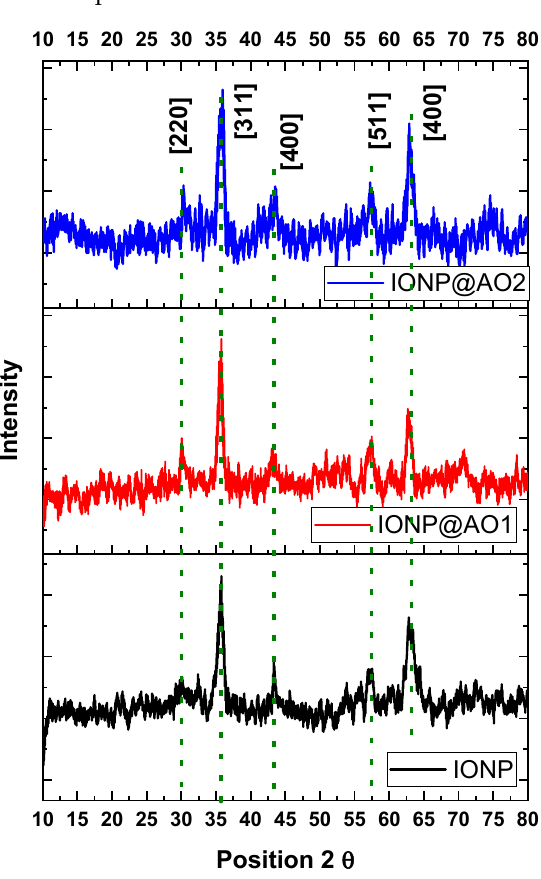
Figure 5. XRD spectra unfunctionalized IONP and functionalized IONP@AO.